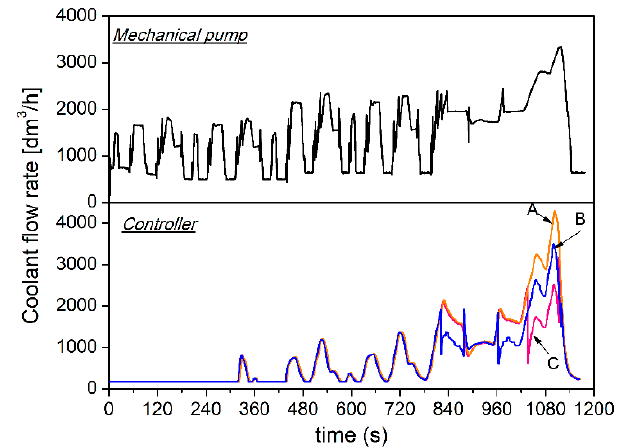
Figure 15. Coolant flow rate delivered by the standard belt-driven pump ( top ) and by the various controllers during the NEDC ( bottom ).